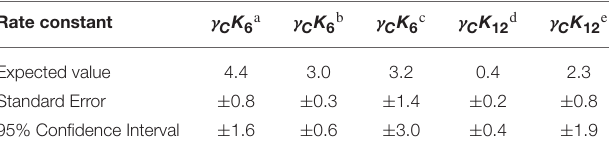
TABLE 3 | Expected values of dissociation rate constants (s − 1 ) for carboxylation ( γ C K 6 ) and oxygenation ( γ C K 12 ) with standard errors and corresponding 95% confidence intervals calculated from coefficients (gradient and intercept) with P < 0.05 in Table 2 .